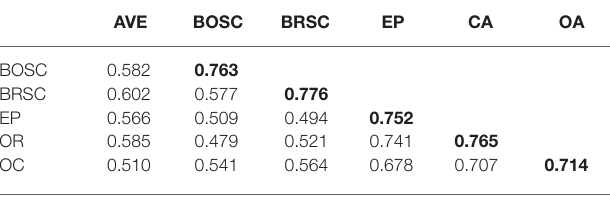
TABLE 3 | Discriminant validity for the measurement model.